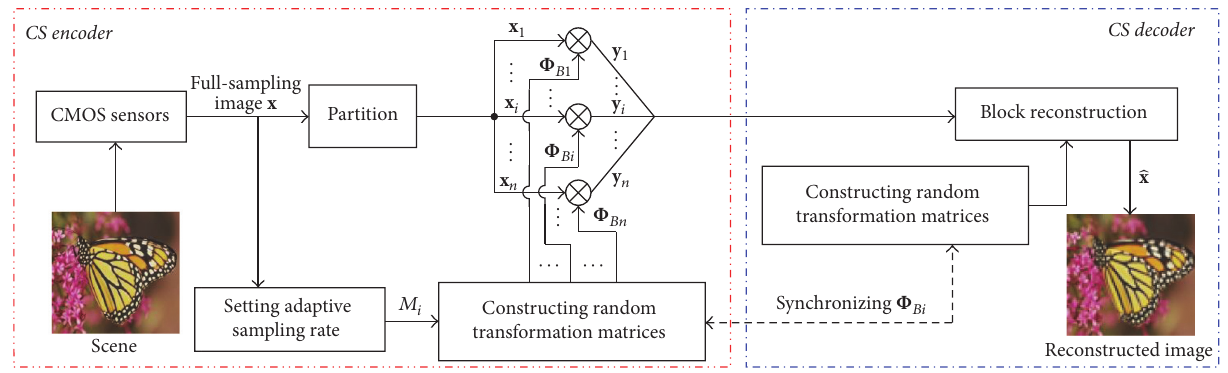
Figure 1: Framework of adaptive block